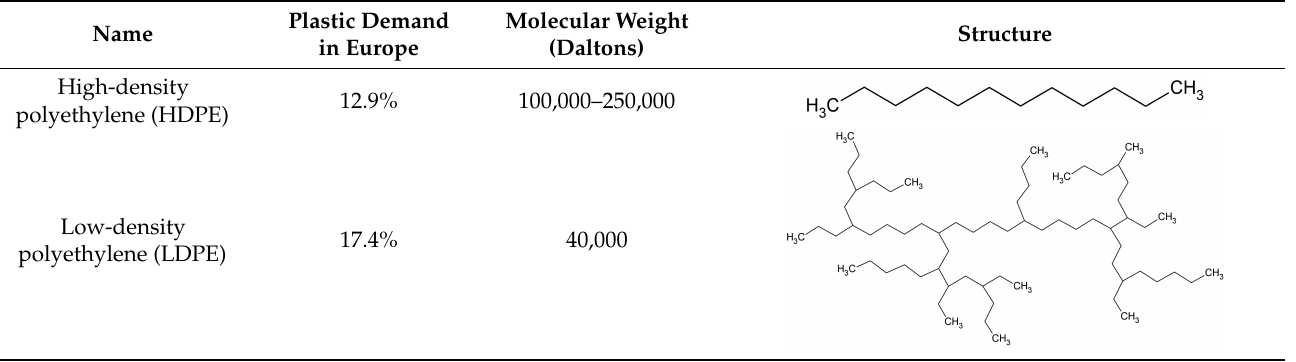
Table 2. European plastic demand, molecular weight (Daltons) and backbone structural formula of polyethylene, high-density polyethylene and low-density